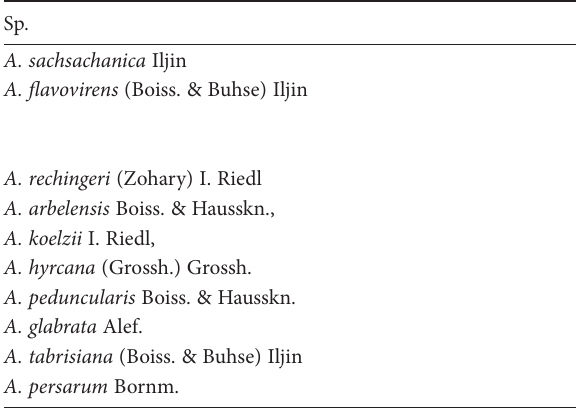
Table 2. Morphological characters in studied